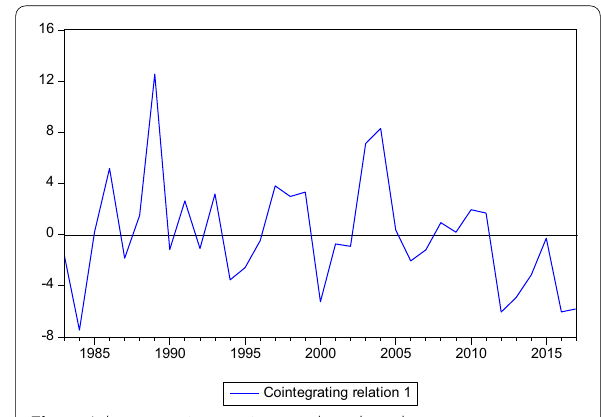
Fig. 4 Johansen cointegrating graph and